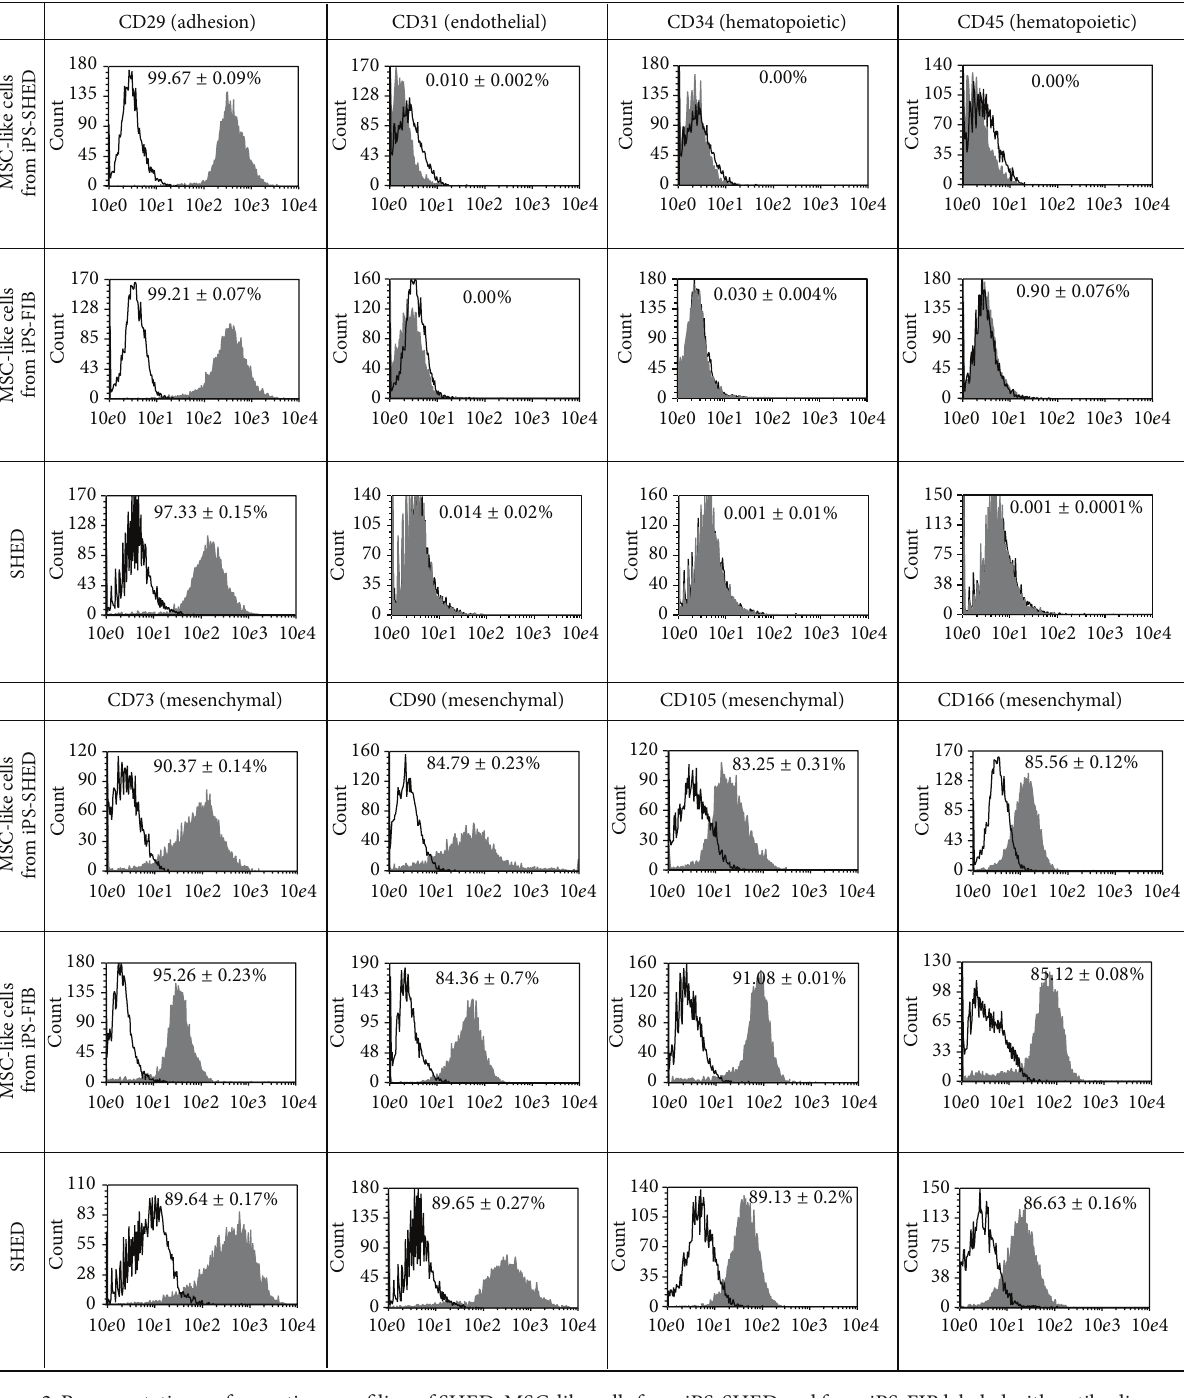
Figure 2: Representative surface antigen profiling of SHED, MSC-like cells from iPS-SHED and from iPS-FIB labeled with antibodies against mesenchymal, endothelial, and hematopoietic antigens. White histograms represent isotype controls and grey histograms represent the fluorescence of conjugated antibodies for each antigen. Mean expression rates are indicated above each graph and displayed as mean +/ −